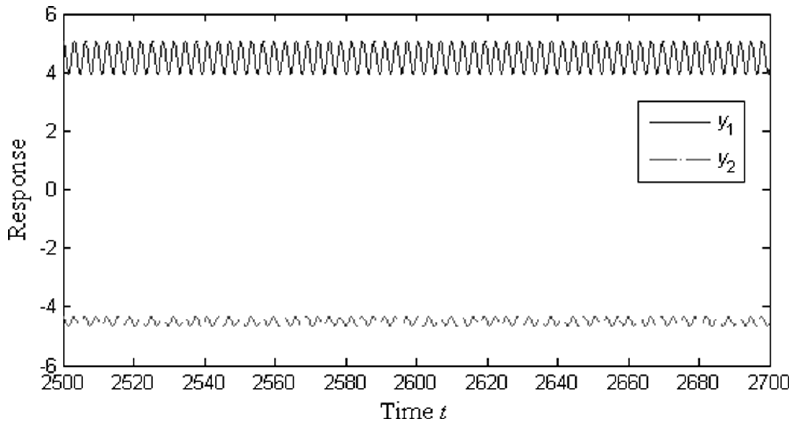
Fig. 22. Time history with feedback control, τ = 1 ,β 11 = β 12 = β 21 = β 22 = − 10, ( y 1 ,y 2 , ˙ y 1 , ˙ y 2 ) =